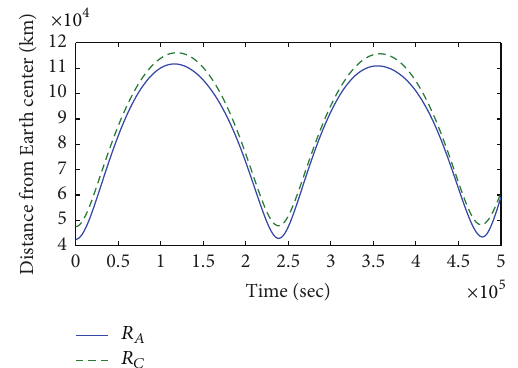
Figure 4: The distances from Earth center as functions of time for free libration.